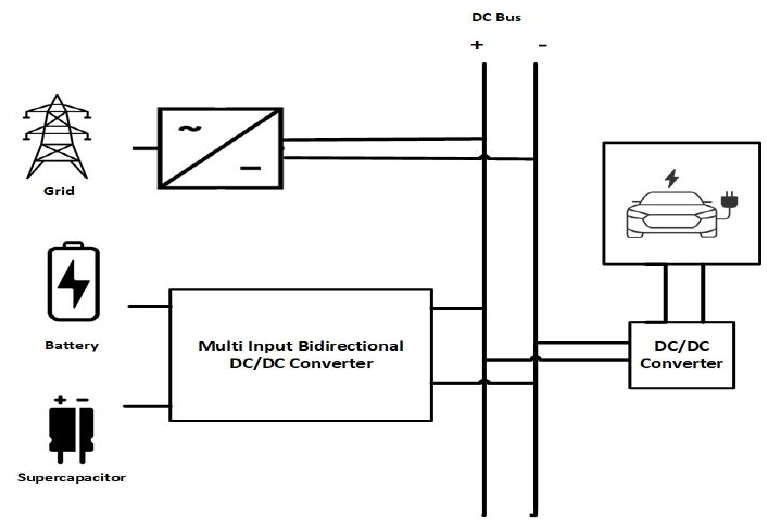
Figure 1. The configuration of the fast-charging station of electric vehicles. Table 2. Inductance equations for different operation modes.